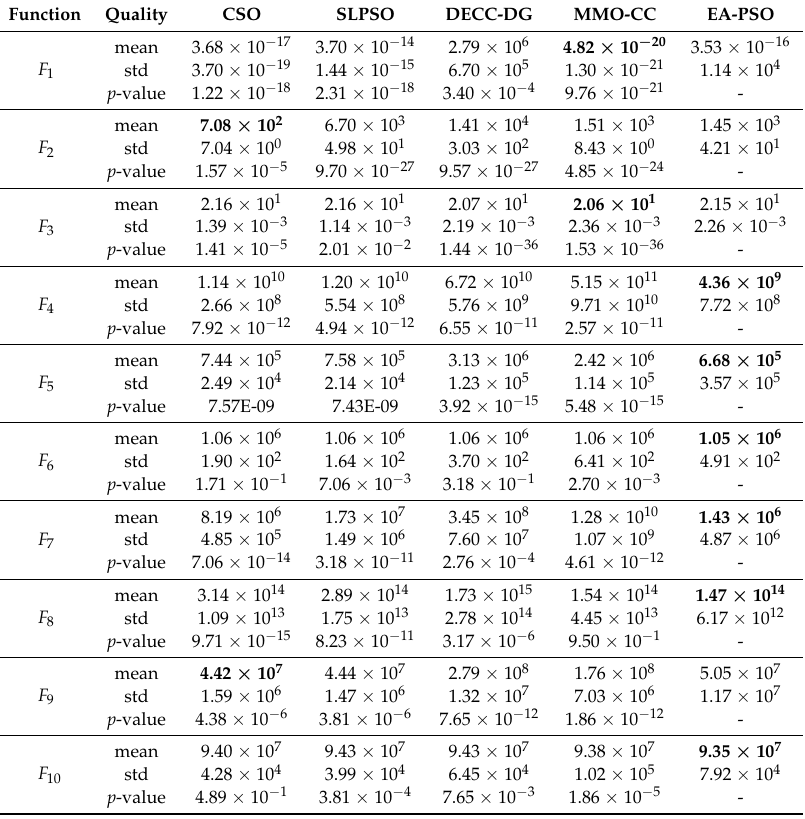
Table 1. The experimental results of 1000-dimensional IEEE CEC’ 2013 benchmark functions with fitness evaluations of 3 × 10 6 . The best performance is marked by bold font in each